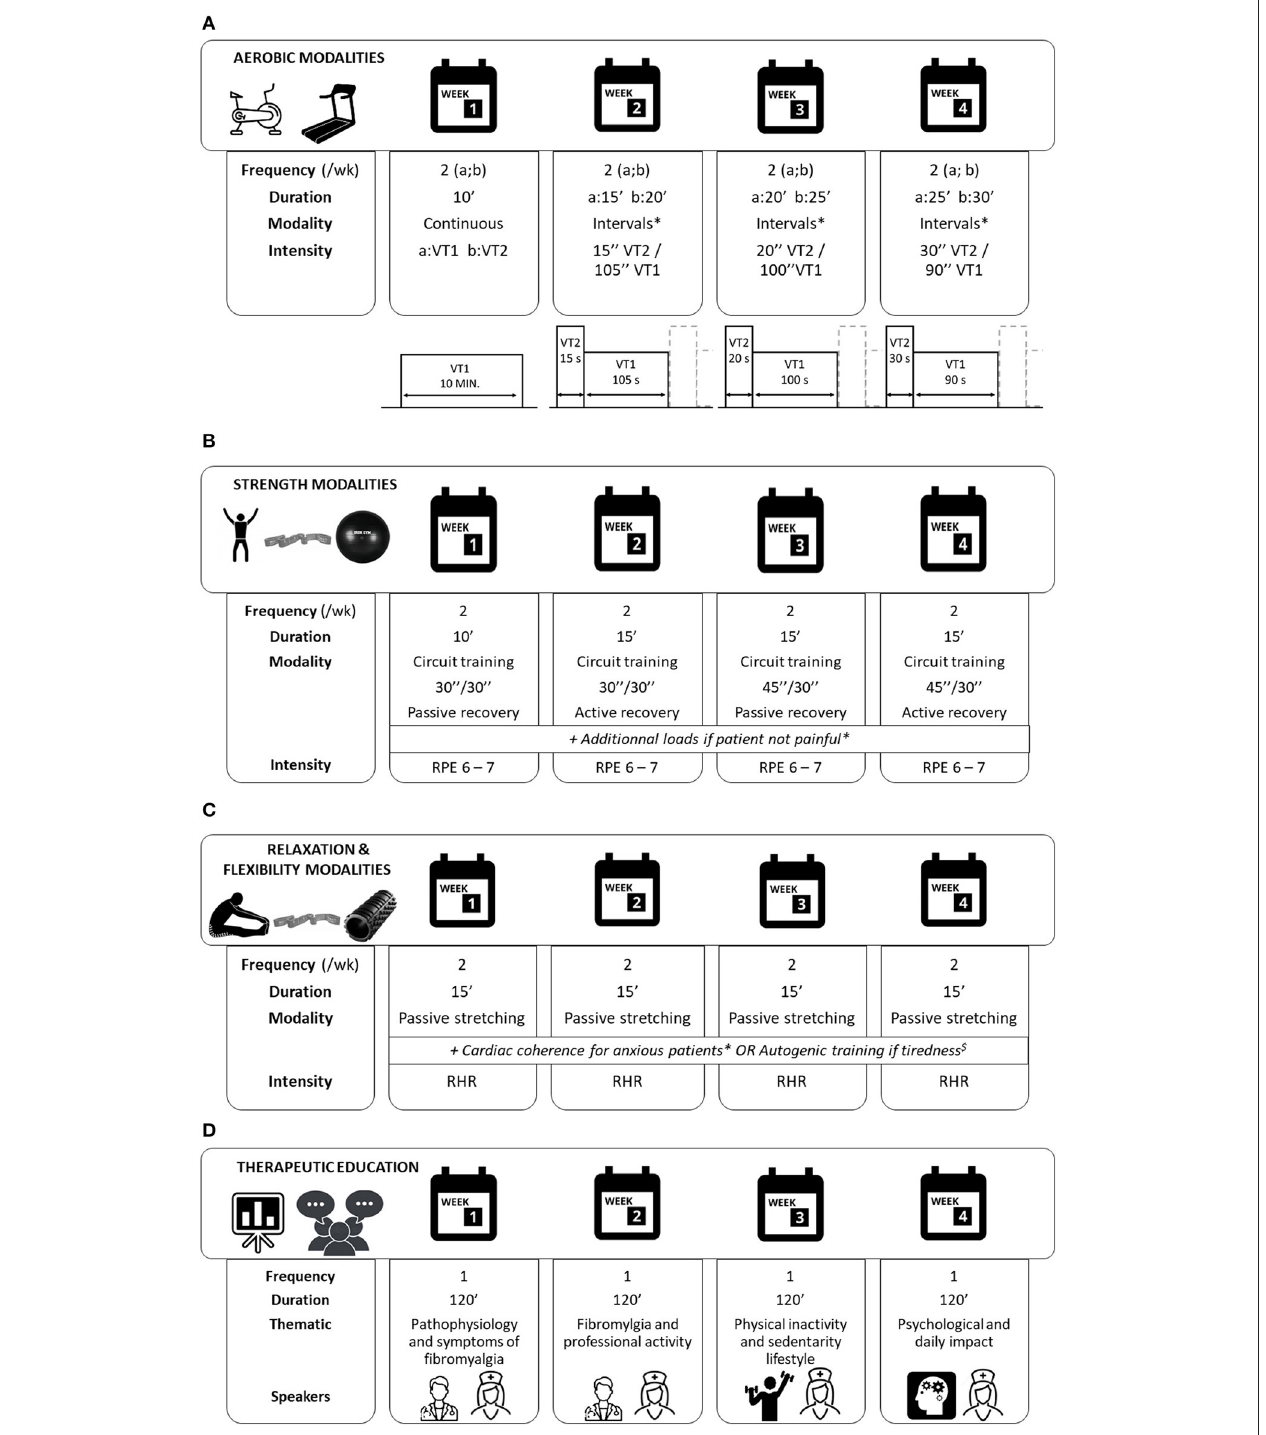
FIGURE 3 | FIMOUV program intervention. (A) Modalities of aerobic training during the first month of intervention. Each session starts with 10min warmup and ends with 10min cooldown. *A continuous training at VT1 can be proposed if the subject’s physical capacity does not allow the increase in workloads, as they are made on interval training. (a;b) corresponds to each session of the week; VT1: ventilatory threshold 1; VT2: ventilatory threshold 2. (B) Modalities of strength training during the first month of intervention. *Load maximum 50% of 1-repetition maximum if pain evaluation < 4/10 at the start of the session. RPE: rating of perceived exertion, Borg modified scale. (C) Modalities of relaxation and flexibility training during the first month of intervention. *Hospital Anxiety and Depression Scale > 8 for anxiety item. $ Fatigue evaluation > 7/10 at the start of the session. RHR: resting heart rate. (D) Modalities of therapeutic education program during the first month of intervention.